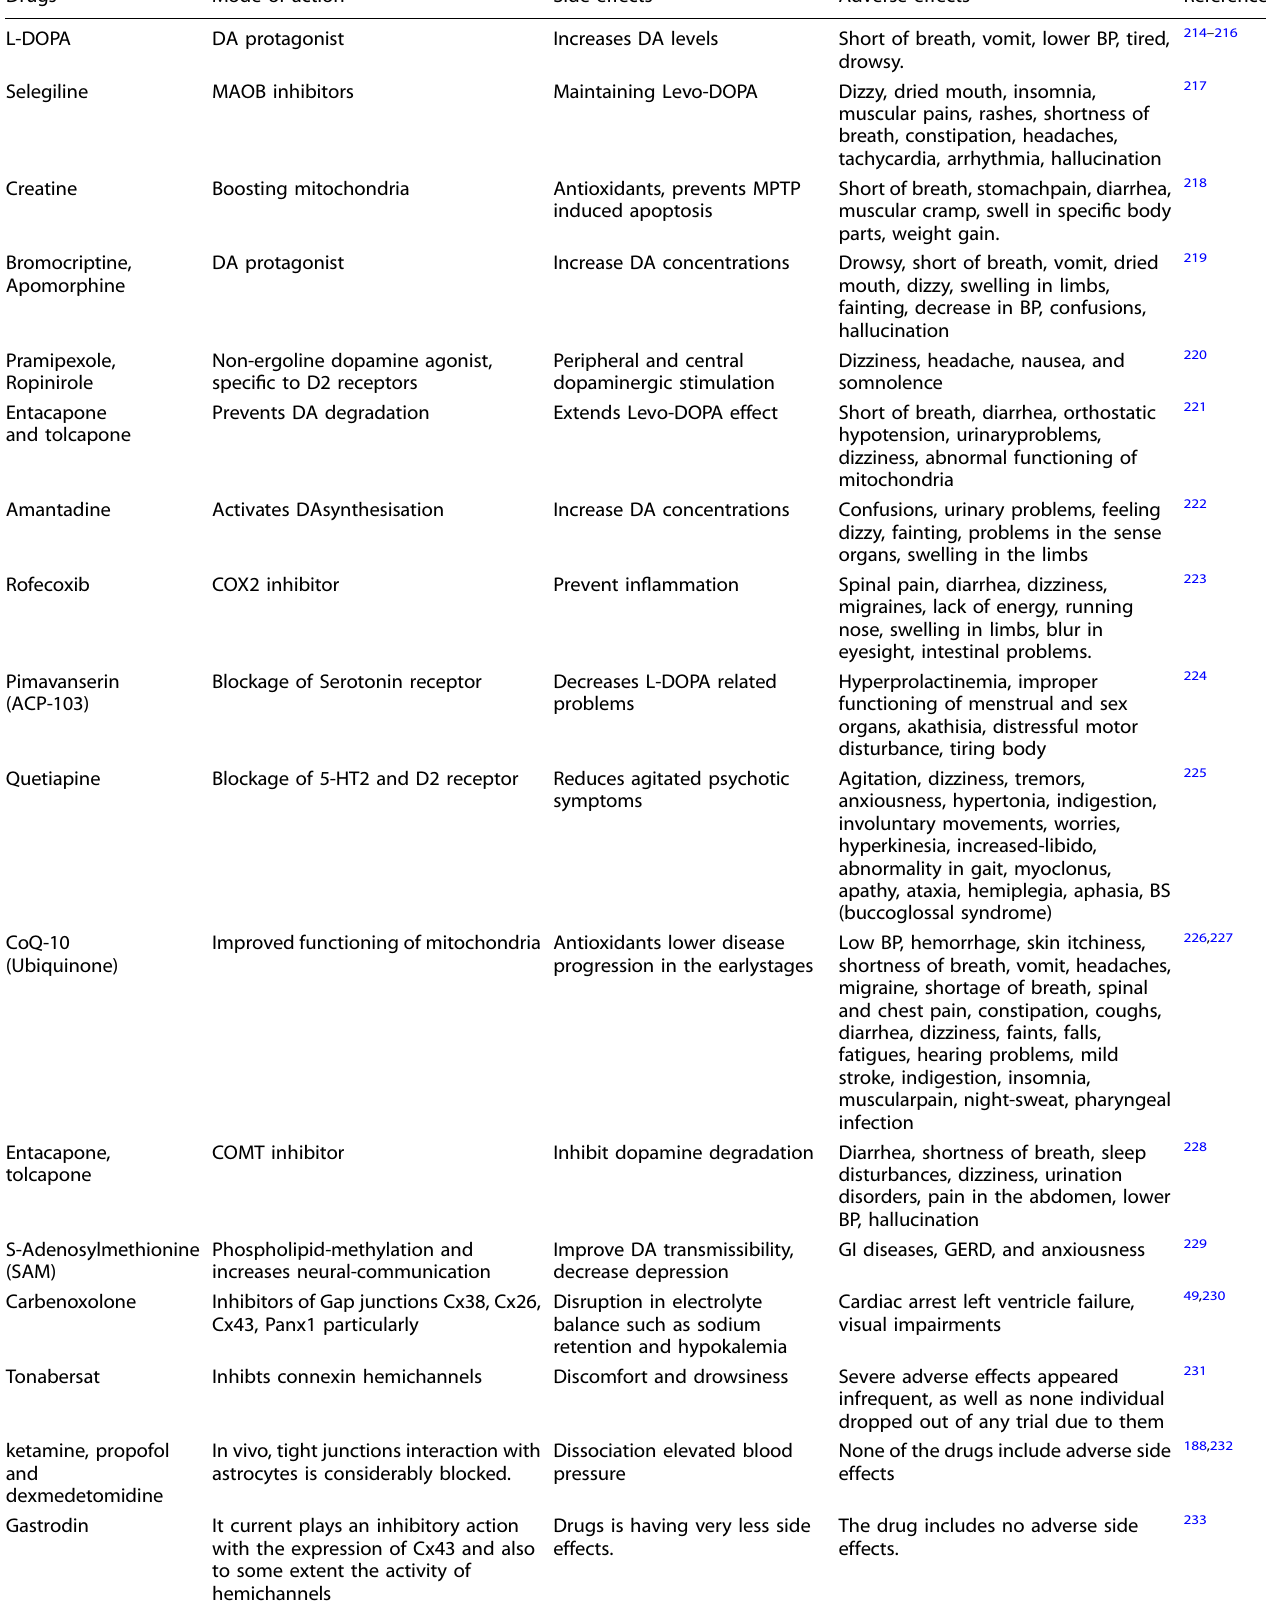
Table 2. Drugs that are involved in the treatment of